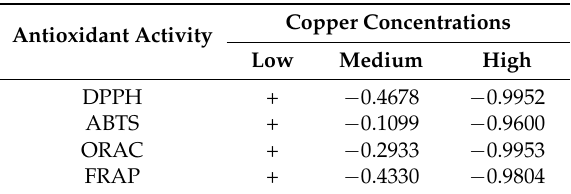
Table 4. Lineal correlation coefficients (R 2 ) between copper concentrations and antioxidant activity of